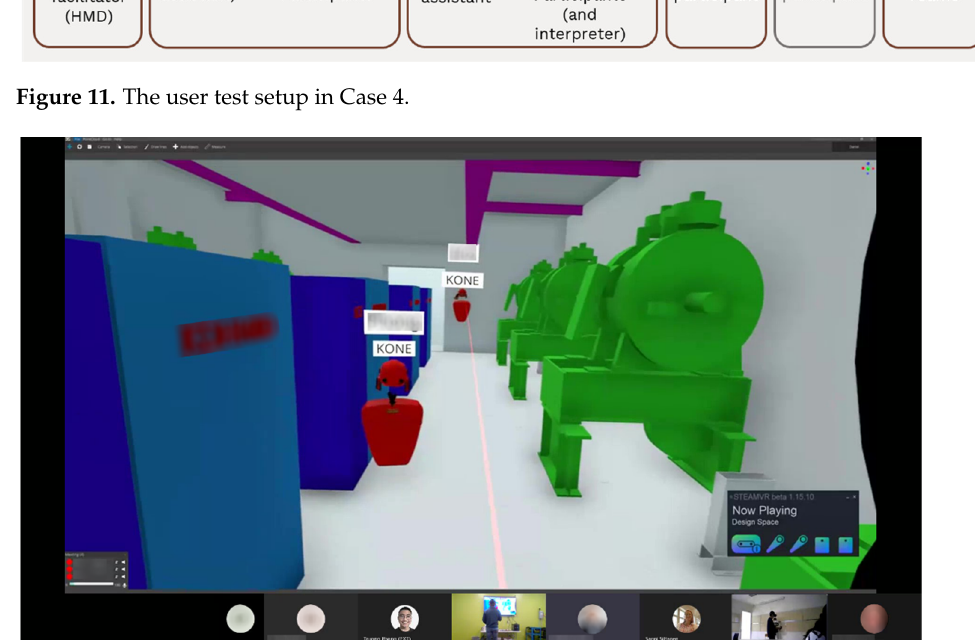
Figure 12. Screenshot of Teams view of one user test session in Case 4, showing HMDe participants’ view and USB camera video views from two testing locations.